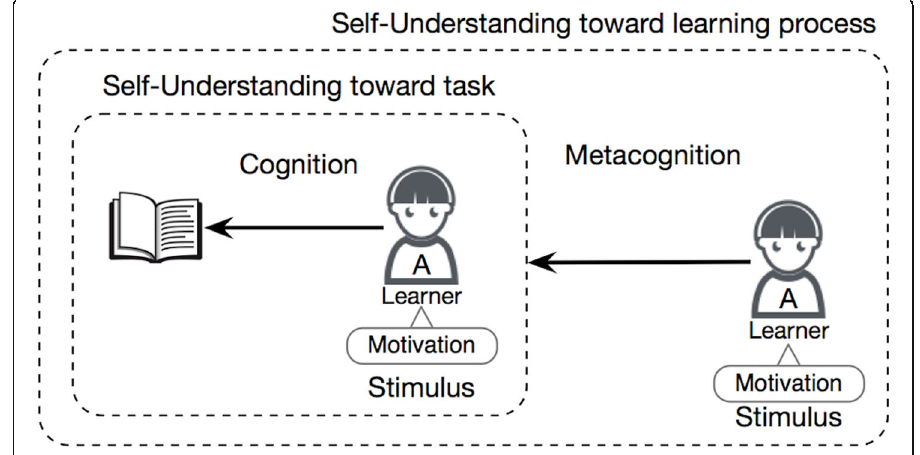
Fig. 2 Relation of cognition, metacognition, and motivation in